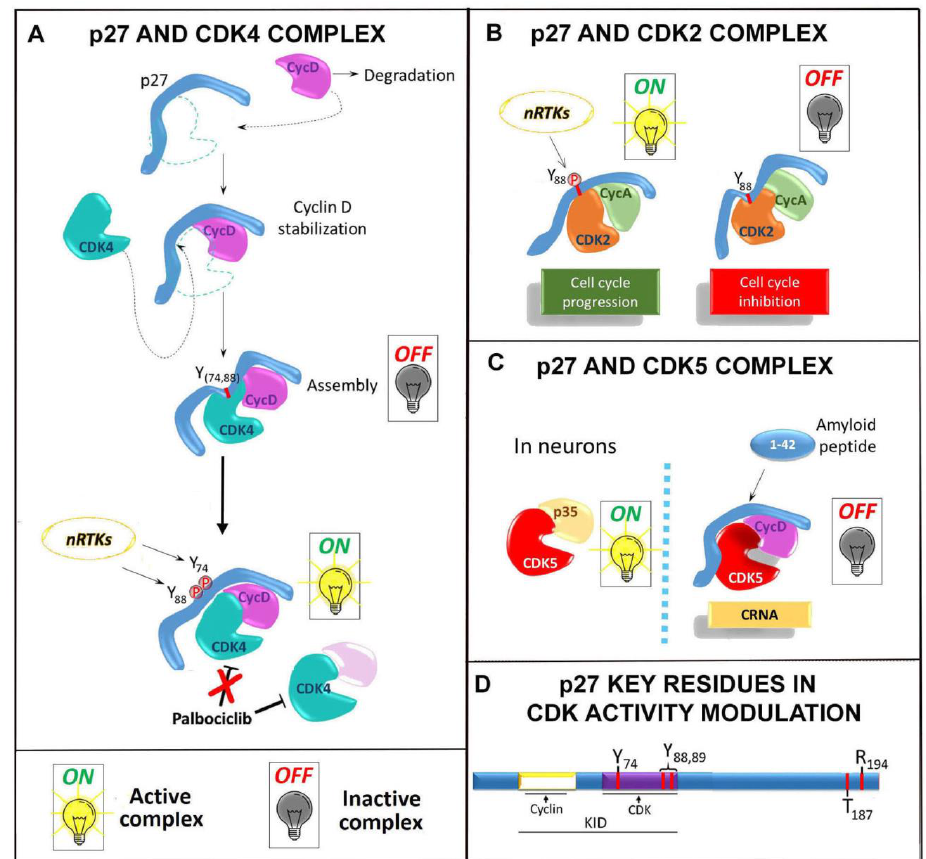
Figure 1. p27 and CDK interaction. The scheme summarizes some of p27 interaction with different Cyclin/CDK het- erodimers. The sequence of the events is reported in detail in the text. ( A ) p27 binds sequentially Cyclin D and CDK4, facilitating the formation of the kinase complex. The modification of Tyrosine 74 (88) (P in red) by non-receptor tyrosine kinases (nRTKs) weakens the affinity of p27 for CDK4 which is then free to allocate the ATP in its specific ATP-binding site, allowing the full activation of the kinase complex. When bound to p27, the Cyclin D/CDK4 is resistant to inhibition by palbociclib, a specific Cyclin-D/CDK4 inhibitor now in clinical trials for high-risk ER + /HER2 − breast cancer. ( B ). p27 interaction with Cyclin A/CDK2 containing complex is recapitulated (see the text for further details). The panel highlights the binding of p27 KID to the Cyclin A and to the kinase CDK2 When working as inhibitor, p27 is strongly tethered to CDK2, with its 3 10 -helix allocated into the catalytic cleft of CDK2 to block ATP access and, then, to inhibit the kinase. The phosphorylation of Tyr88 in the 3 10 -helix disrupts the inhibitory interactions of p27 with CDK2 and allows the reestab- lishment of specific interfacial contacts between Cyclin A and CDK2, as in the active Cyclin A/CDK2 binary complex. Subsequently, the ejection of the 3 10 -helix is favored and the catalytic cleft of CDK2 becomes structurally very similar to that of the active Cyclin A/phospho-CDK2 complex. ( C ). The kinase CDK5 plays important roles in cell cycle arrest of postmitotic neurons. Its canonical interacting partner is p35 and when formed the complex p35/CDK5 is nuclear and active. In response to cell exposure to A β (1 − 42) peptide (an amyloid derived peptide), p27 seems to act as scaffold in favoring the association of CDK5 and Cyclin D1 in a trimeric complex with p27 itself that does not translocate in the nucleus, but hampers CDK5 interaction with its physiological partner and activator p35. This attenuates the CDK5 cell division restraining activity and might stimulate apoptosis. CRNA, cell cycle-related neuronal apoptosis. ( D ). p27 structure, with highlighted specific domains and amino acid residues playing a key role in the interaction with/activity modulation of CDK-containing complex. In the N-term moiety, the KID is highlighted with the amino acids target of phosphorylation (Y74, Y88, Y89) probably involved in the full activation of the kinase complexes. In the p27 C-term region, T187 represents the target of phosphorylation by CDK2 which addresses the protein to degradation; T157 and T198 phosphorylation by AKT may favor the assembly of Cyclin D/CDK4; R194 residue is also evidenced (at +7 from T187) which could allocate at the interface between Cyclin A and CDK2, forming specific hydrogen bonds with P272 on Cyclin A and E42 on CDK2 (see also the text for additional